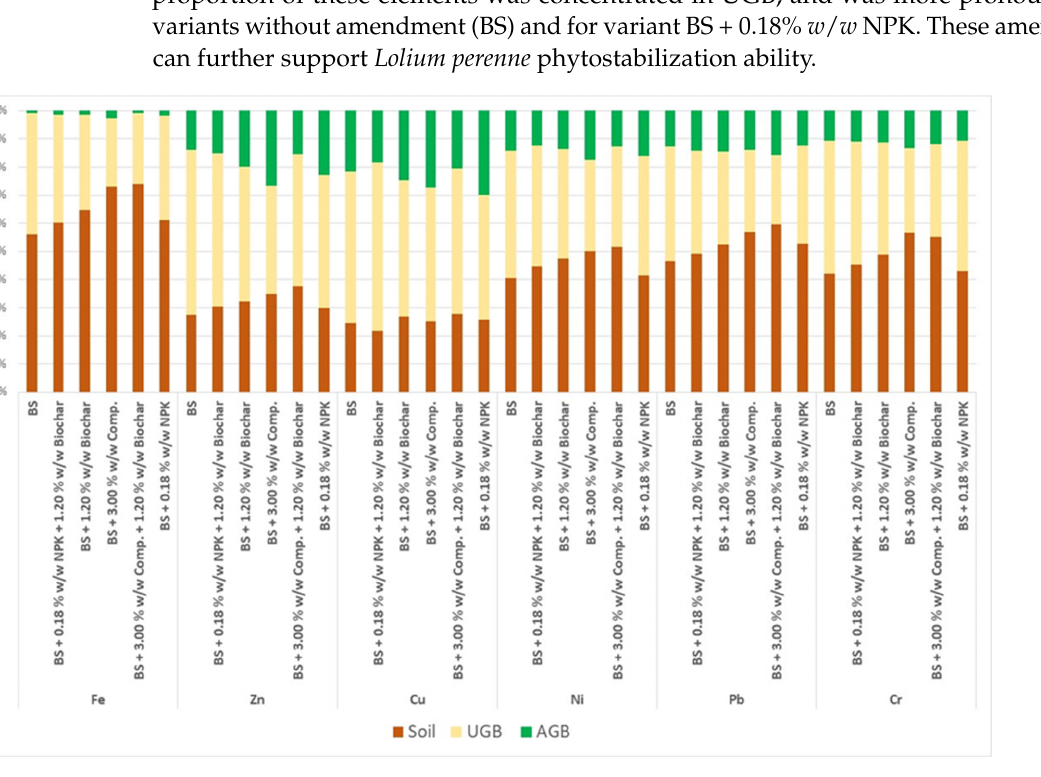
Figure 5. Proportions of monitored metal elements in soil and biomass of Lolium perenne.